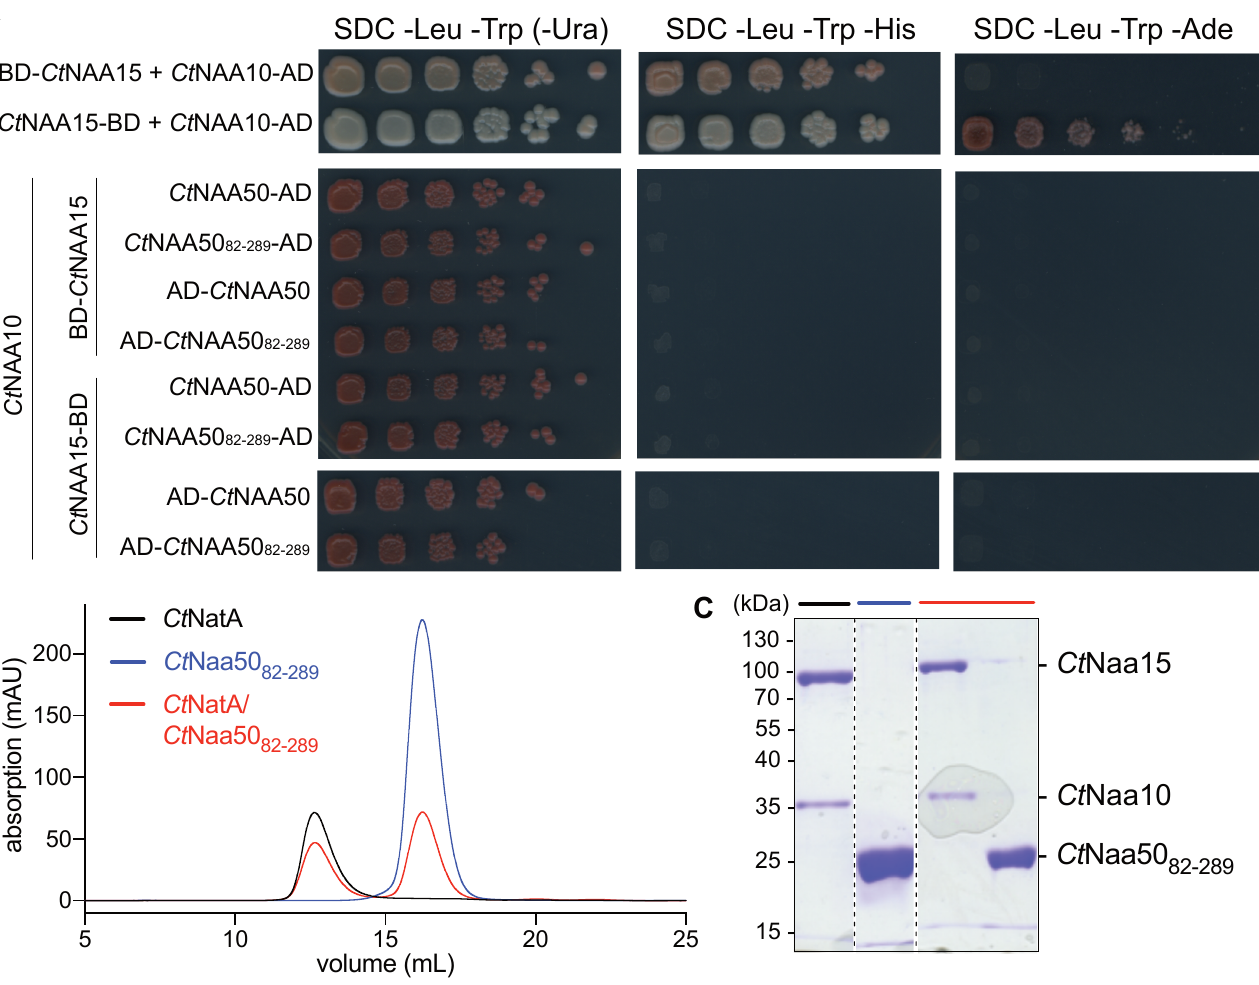
Figure 8. Analysis of Ct NatA/ Ct Naa50 interaction using yeast two-hybrid assays and in vitro interaction studies. ( A ) Only Ct Naa15 and Ct Naa10 subunits interacted with each other in yeast two-hybrid assays. Ct Naa15 and Ct Naa50 constructs did not interact. Proteins were fused to Gal4 activation (AD) or binding domains (BD). Growth on SDC -Leu/-Trp indicates